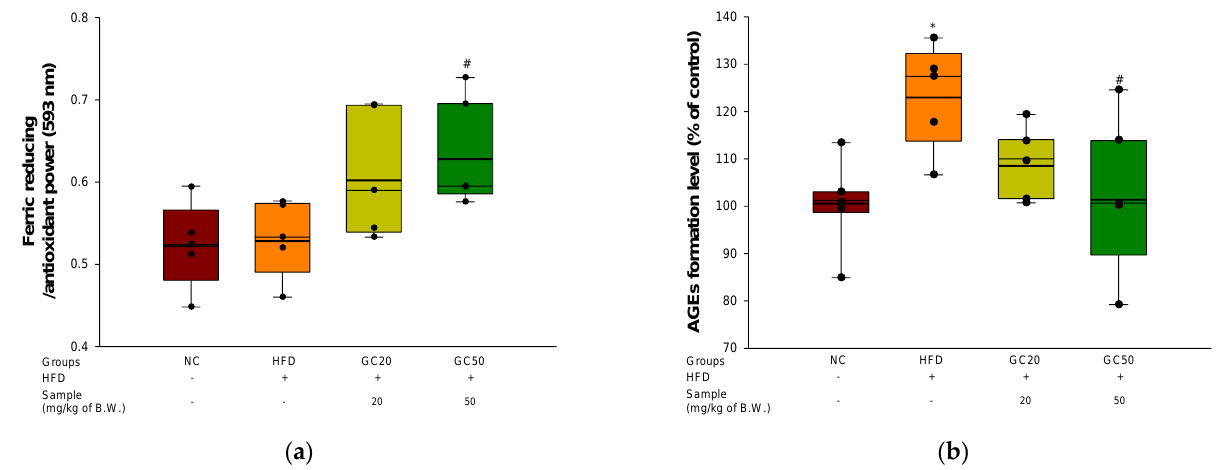
Figure 7. Protective of 80% ethanolic extract from Gimcheon 1ho (GC) cultivar walnut ( Juglans regia ) in HFD-induced mice: ( a ) serum level of FRAP; ( b ) serum level of AGEs formation. Results shown are mean ± SD ( n = 5). Data are statistically represented with * = significantly different from the NC group, and # = significantly different from PM group; * and # p < 0.05, ** and ## p < 0.01. Bold line indicates mean.